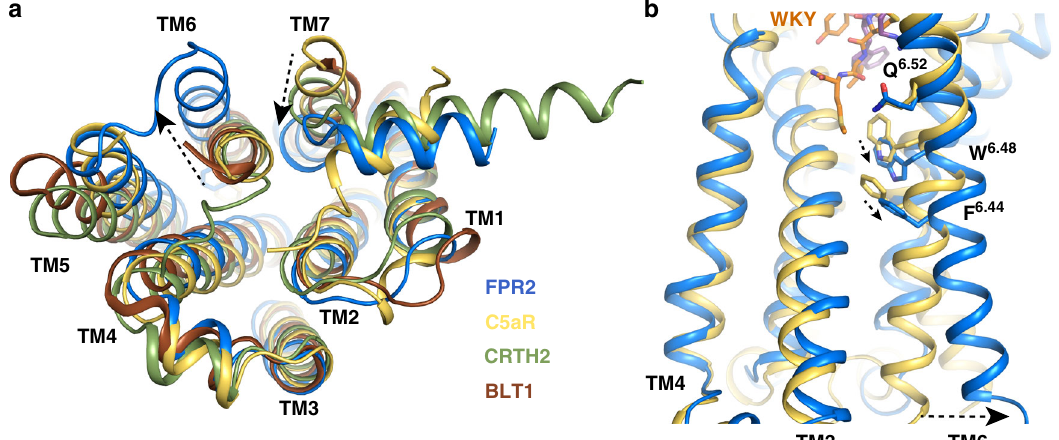
Fig. 5 Potential FPR2 activation mechanism. a Structural comparison of intracellular regions of FPR2 (blue) and other antagonist-bound chemoattractant GPCRs C5aR (yellow, PDB ID 6C1R), CRTH2 (green, PDB ID 6D26) and BLT1 (brown, PDB ID 5X33). b Structural comparison of TM6 of FPR2 and C5aR. In both fi gures, dashed arrows indicate potential conformational changes of FPR2 in activation based on structural